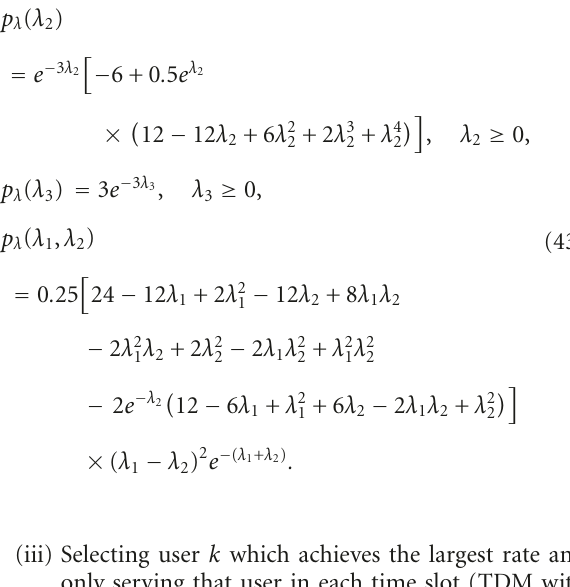
Figure 3: Sum rate of the proposed scheme for L = 1 and 2 compared to a number of multiuser MIMO techniques for M = 3 Tx and N = 3 Rx antennas at 10 dB SNR.